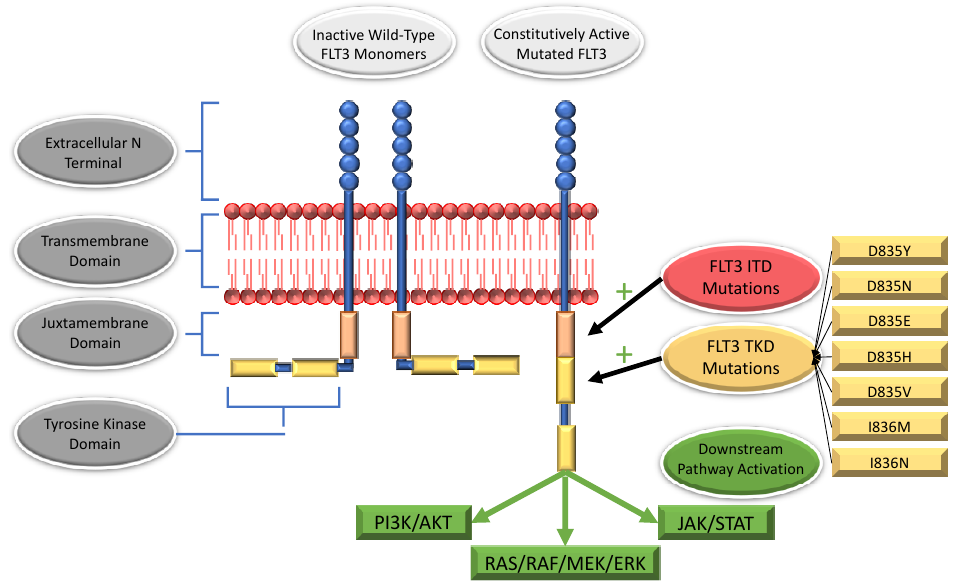
Figure 2. Mutated FLT3 is constitutively active and drives downstream signaling independent of external ligand binding.